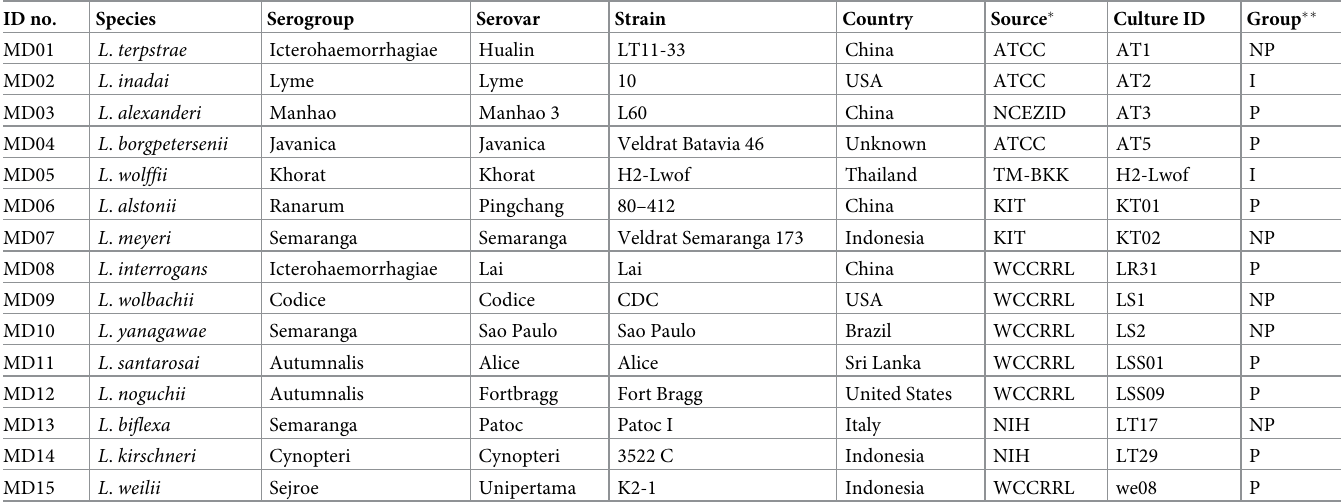
Table 1. List of 15 references used in this